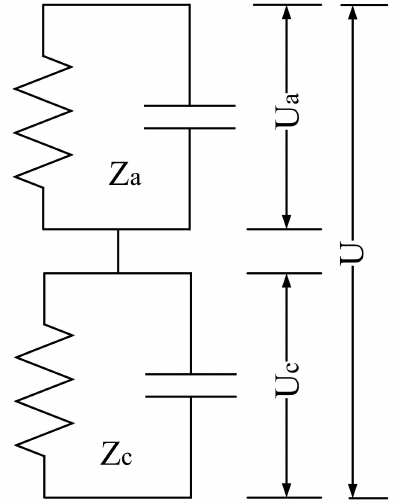
Figure 20. Diagram of equivalent circuit of the needle-plane